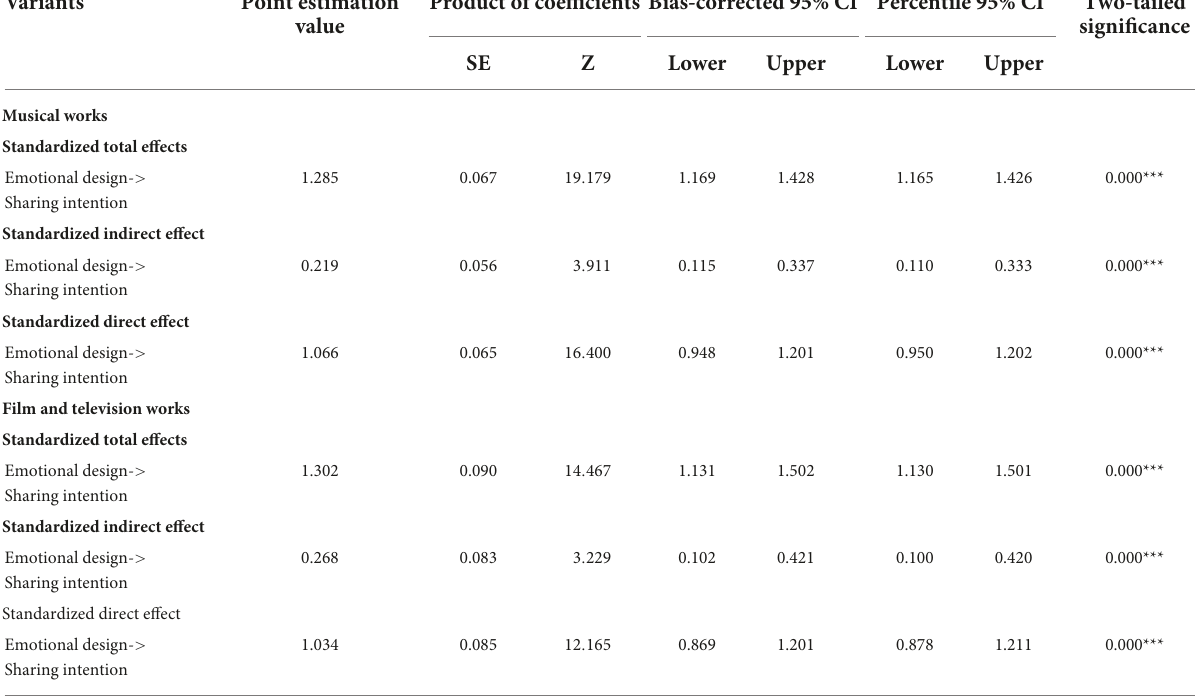
TABLE 7 The standardized indirect, direct, and total mediating effects in the musical works structural